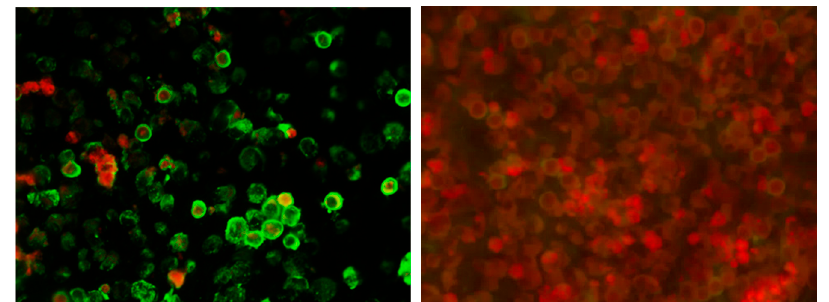
Figure 1. IFA-LCMV IgG positive sample ( left ), negative sample ( right ); 400× magnification. Evans Blue dye was used as a counterstain. Positive reaction is seen as apple-green fluorescence in the cytoplasm. Negative reaction is seen as red-counterstained cells.